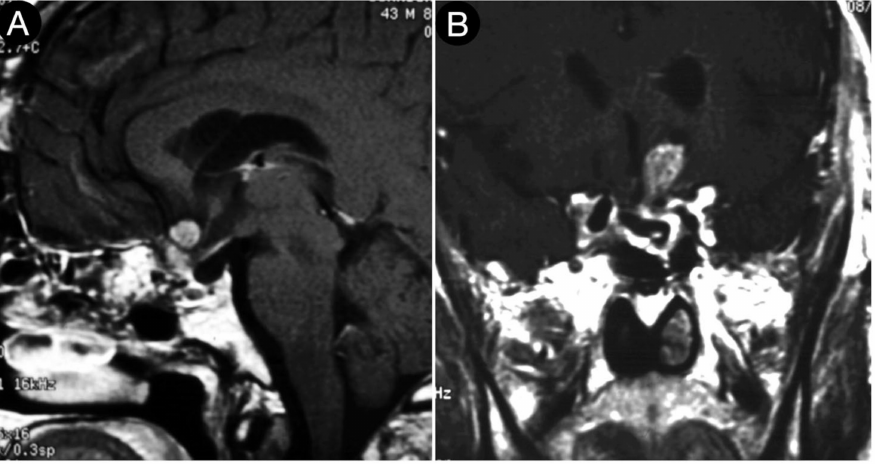
Figure 10. Postoperative sagittal ( A ) and coronal ( B ) T1-weighted contrast-enhanced MRI. Scale bar: 5